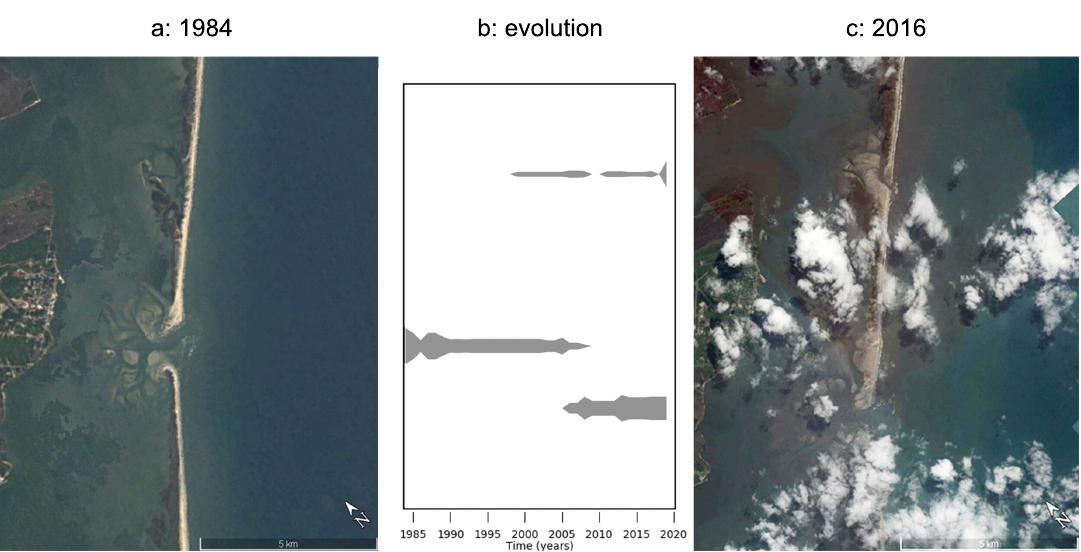
Figure 2. Evolution of three tidal inlets—Old Drum (top), New Drum (middle), and Ophelia Inlet (bottom)—that have alternatingly opened and closed at Core Sound, NC, USA. Shown are satellite images from 1984 (panel a ) and 2016 (panel c ), as well as the evolution (panel b ) based on satellite image analysis. After the closing of Old Drum Inlet, New Drum Inlet was opened artificially in 1971. At the site of Old Drum Inlet, (New) Old Drum Inlet opened in 1999 as a storm-induced breach during Hurricane Dennis, and in 2005 Hurricane Ophelia opened Ophelia Inlet south of New Drum Inlet [23]. Later, both Old and New Drum Inlet closed, but were reopened by Hurricane Irene in 2011. At the start of 2020 both Ophelia and Old Drum Inlet are open and New Drum inlet has closed. Data from Satellite images from Google Earth (Map Data: